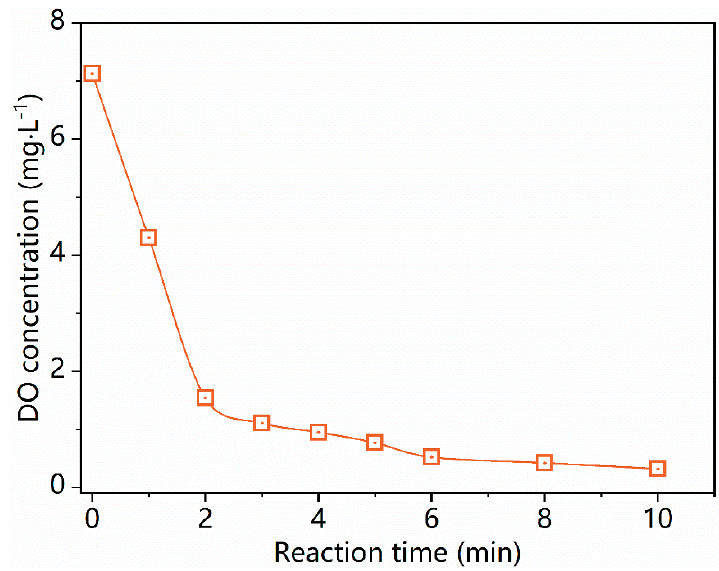
Figure 3. Evolution of dissolved oxygen (DO) concentration during degradation of MCAA by UV/S(IV)/BiOI. Conditions: [BiOI] 0 = 1.0 g ⋅ L − 1 (84.9 μ M as I); [S(IV)] 0 = 1.0 mM; [MCAA] 0 = 10 μ M;